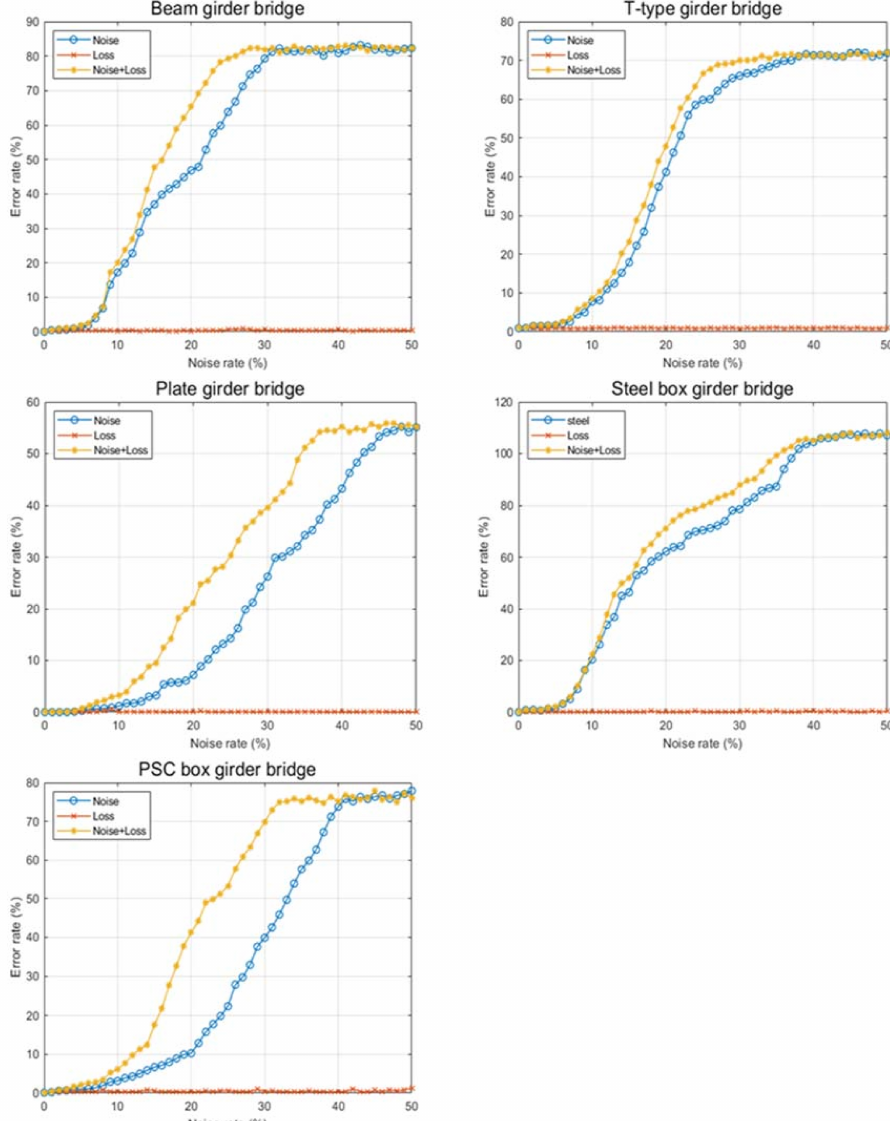
Figure 19. BIM Model-based validation test result for di ff erent type of